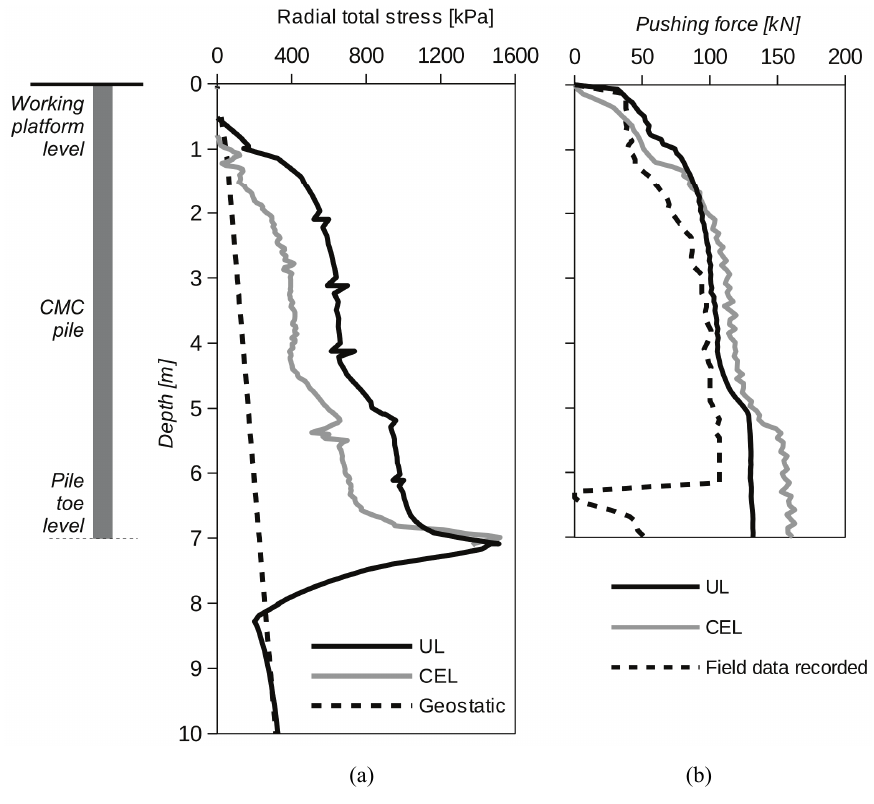
Fig. 8. (a) Radial total stress acting on the pile wall after installation, (b) total pushing force obtained from numerical analysis and field drilling